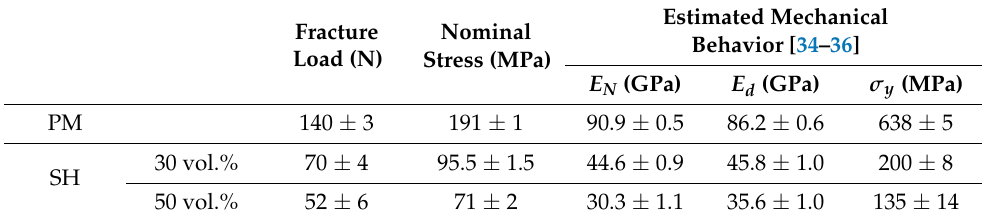
Table 1. Static behavior of the virgin porous dental